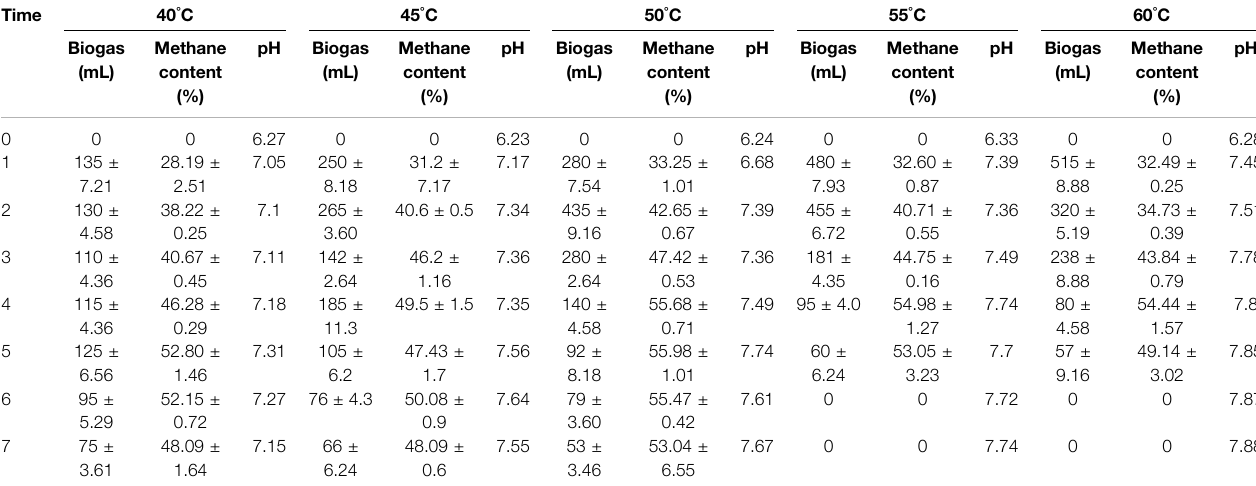
TABLE 4 | In fl uence of temperature on the performance of the second stage of anaerobic digester of TS-AD